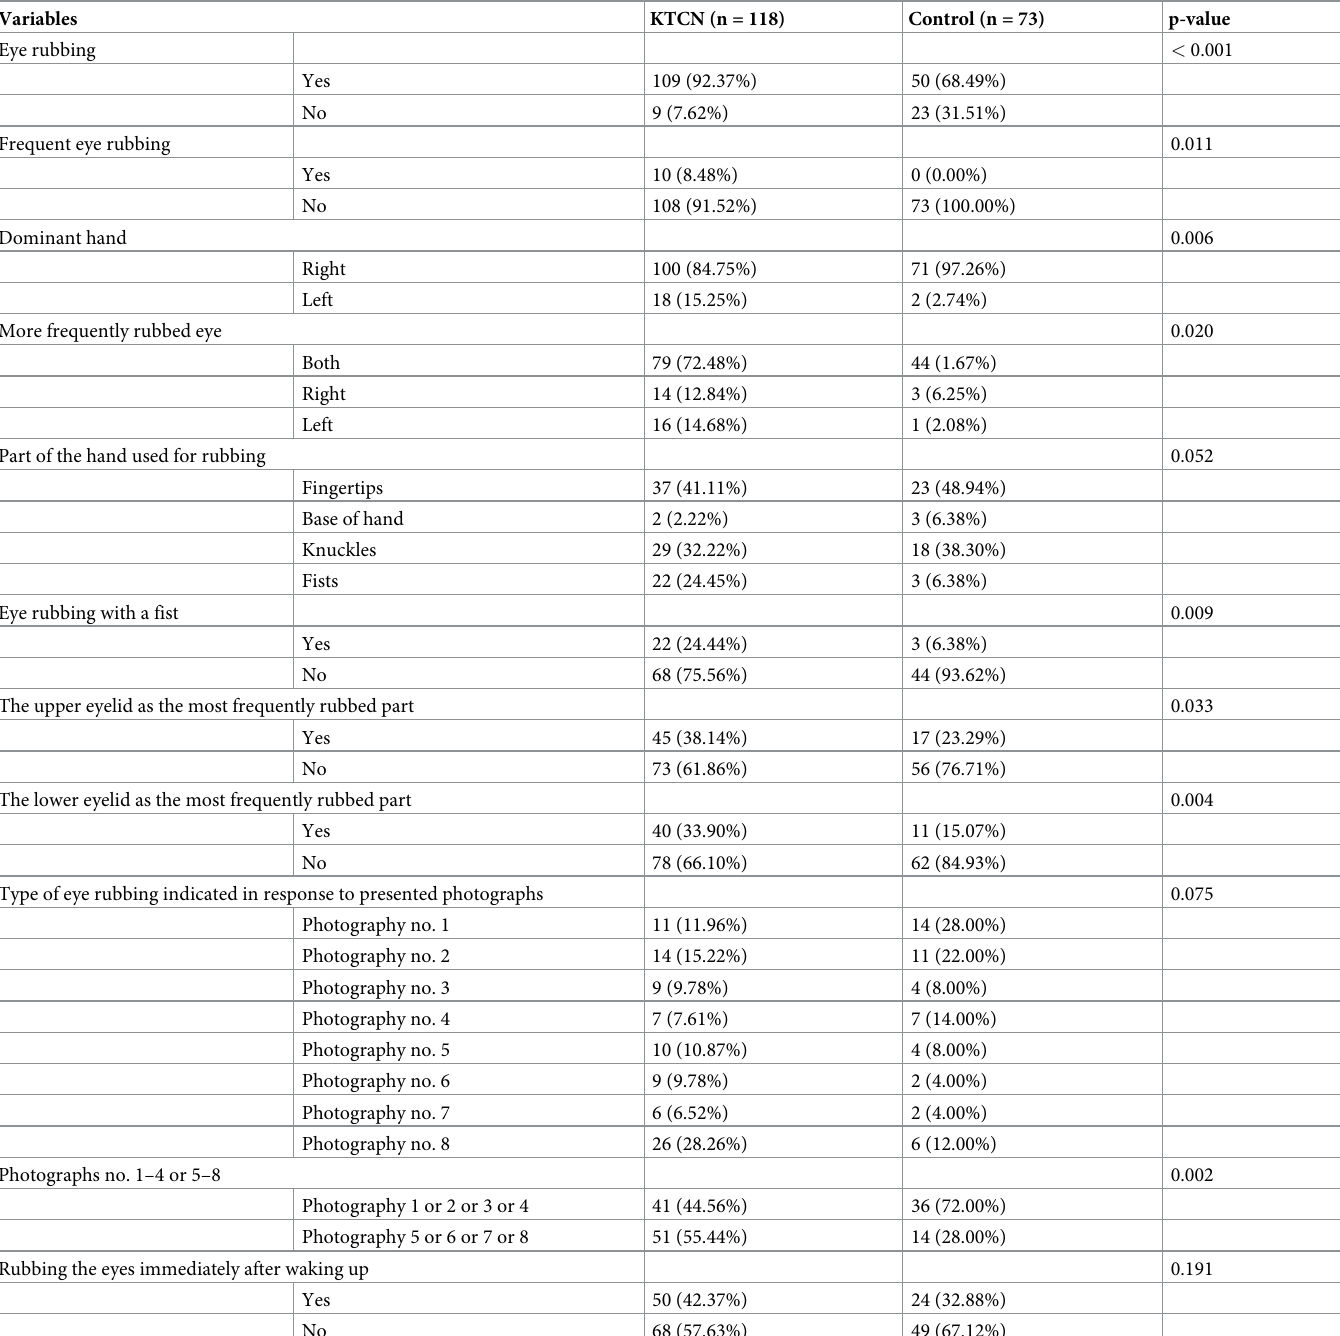
Table 3. The data/results of analyzes of the eye rubbing